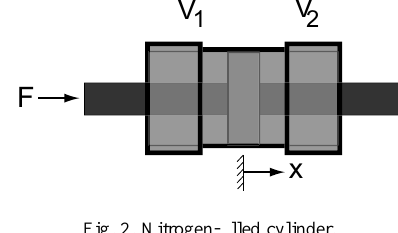
Fig. 2. Nitrogen-filled